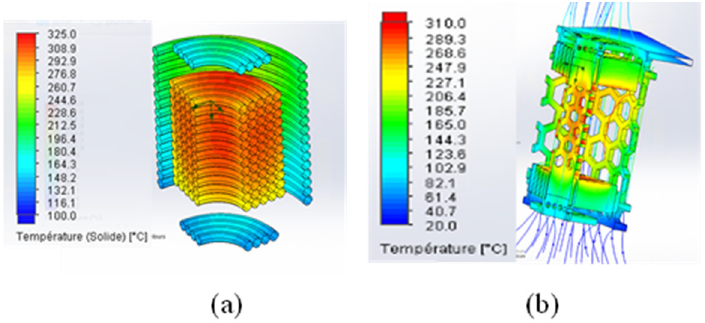
Figure 14. Thermal simulation of the air-core transformer: ( a ) Conductor focus; ( b ) Support focus.